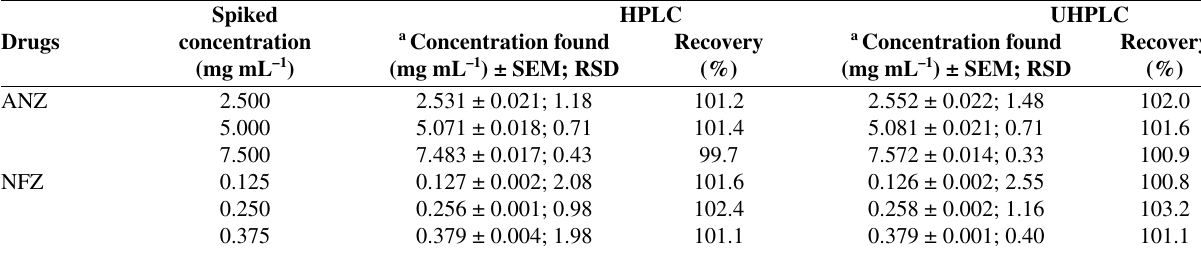
Table 5. Precision studies of ANZ and NFZ by HPLC and UHPLC